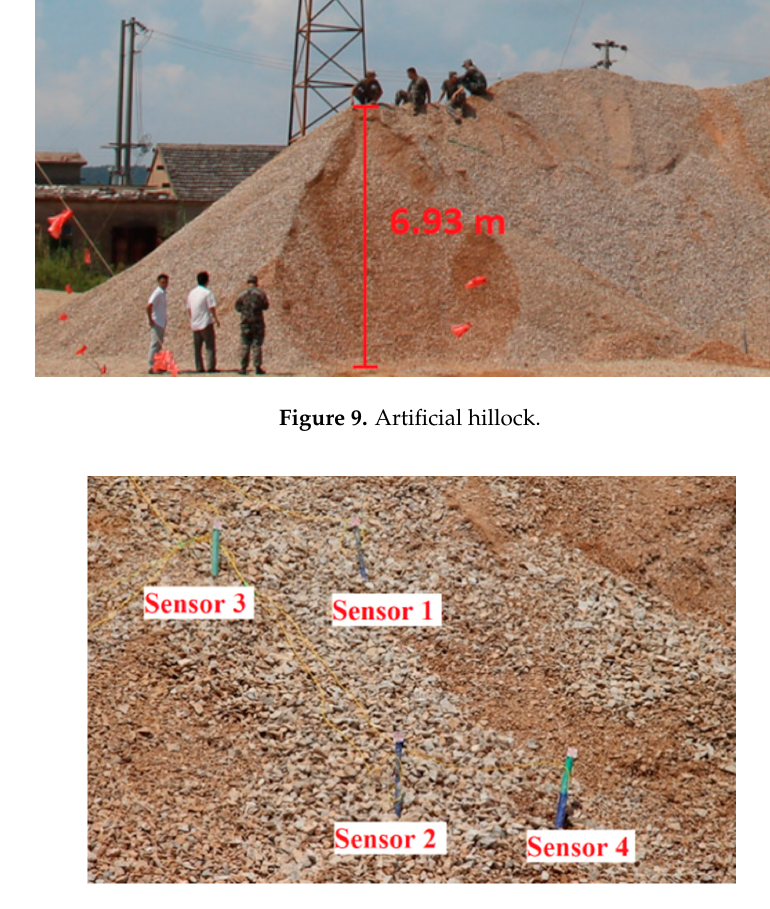
Figure 10. Location of the four sensors.